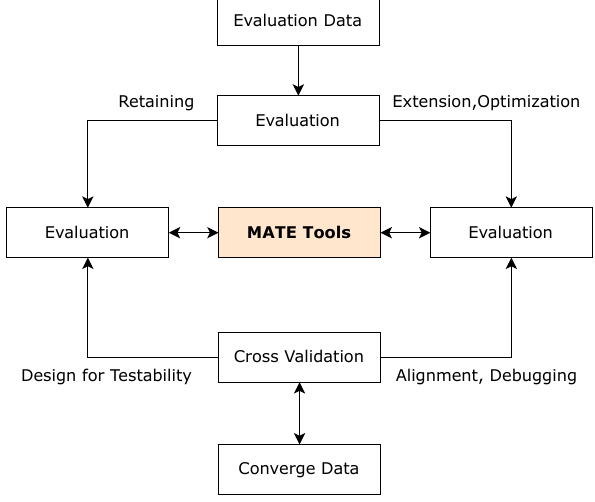
Figure 10. The MATE framework.